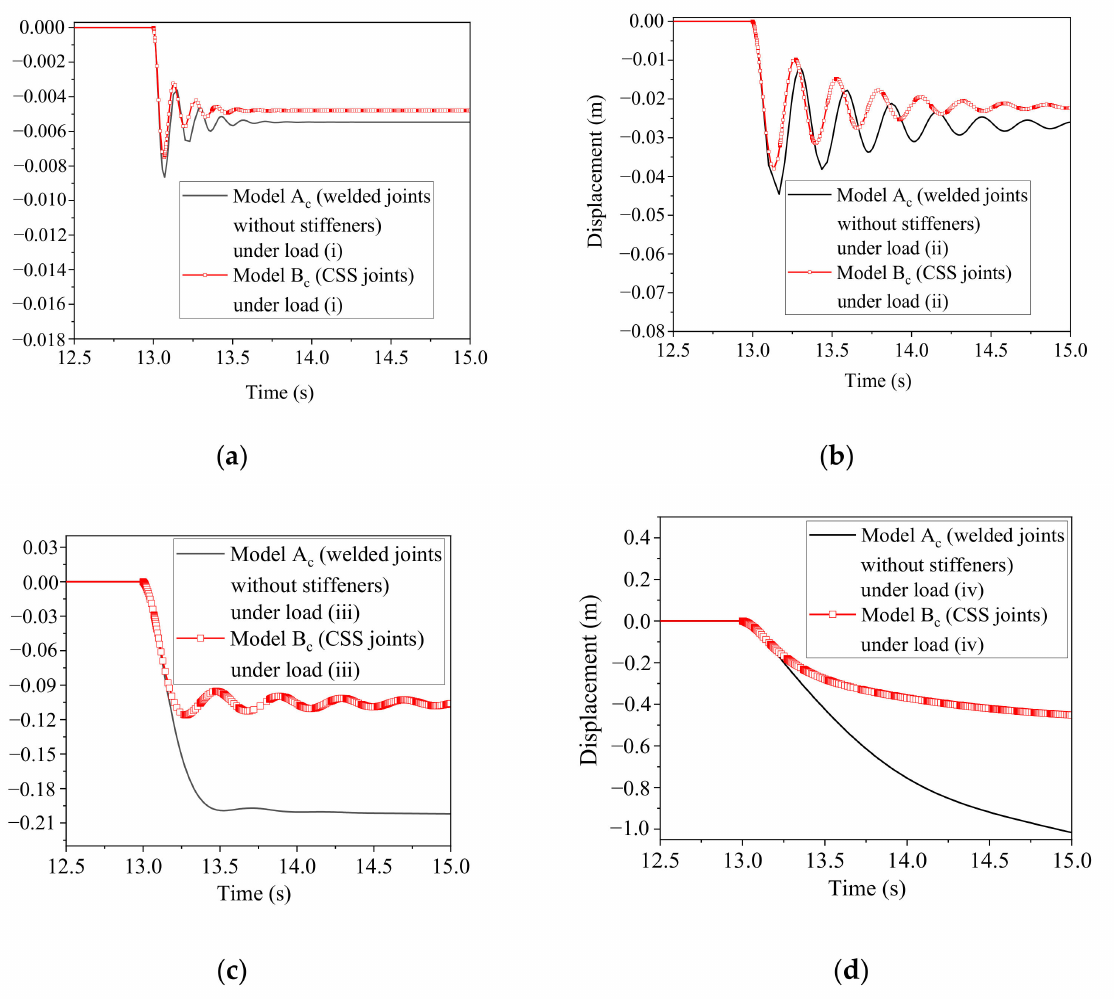
Figure 5. Displacement–time history curves of the interior column bottoms in models A c and B c : ( a ) Load (i); ( b ) Load (ii); ( c ) Load (iii); ( d ) Load